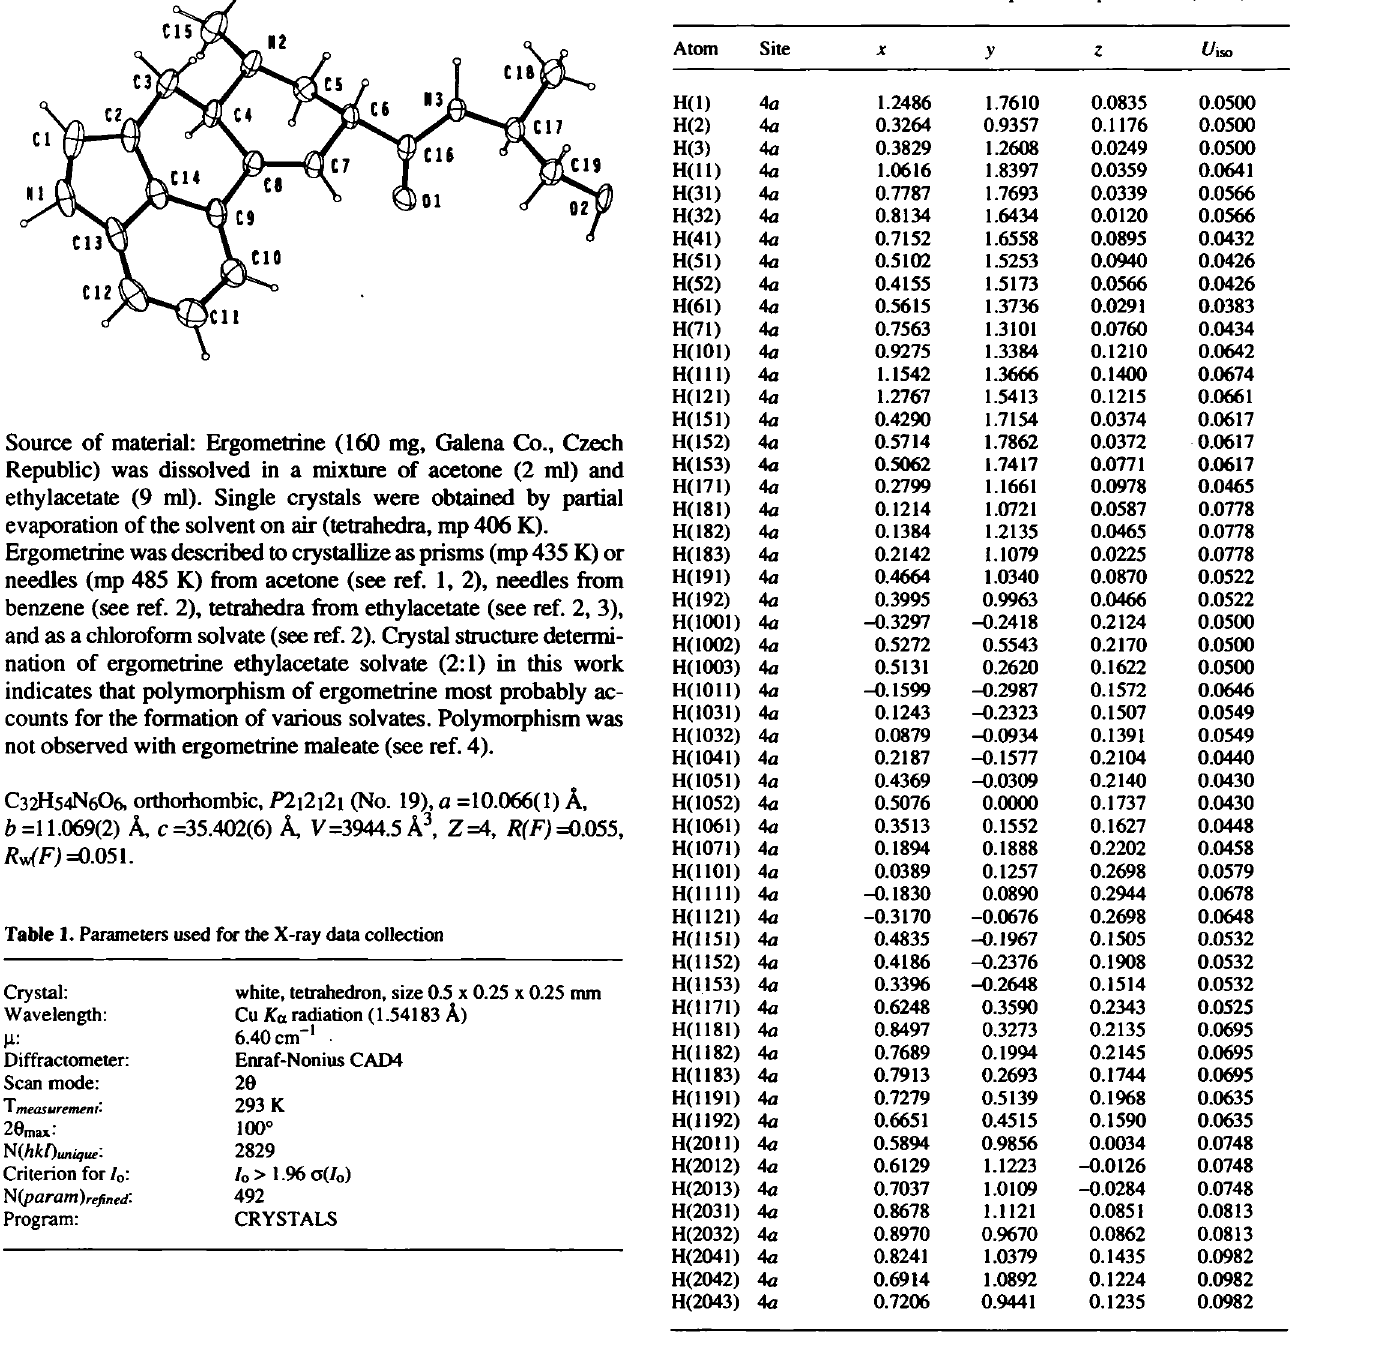
Table 2. Final atomic coordinates and displacement parameters (in Л^)